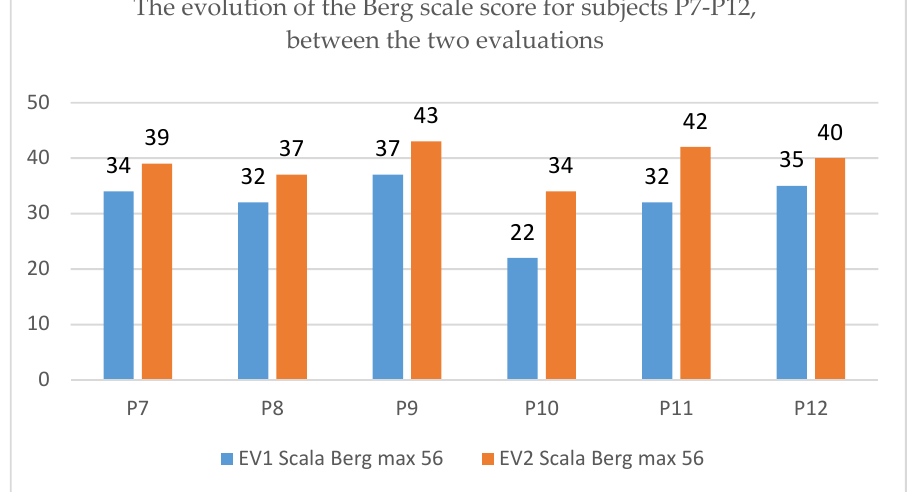
Figure 9. The evolution of the Berg scale score for subjects P7–P12. Table 3. The table of statistical indicators of the difference of the Berg scale.